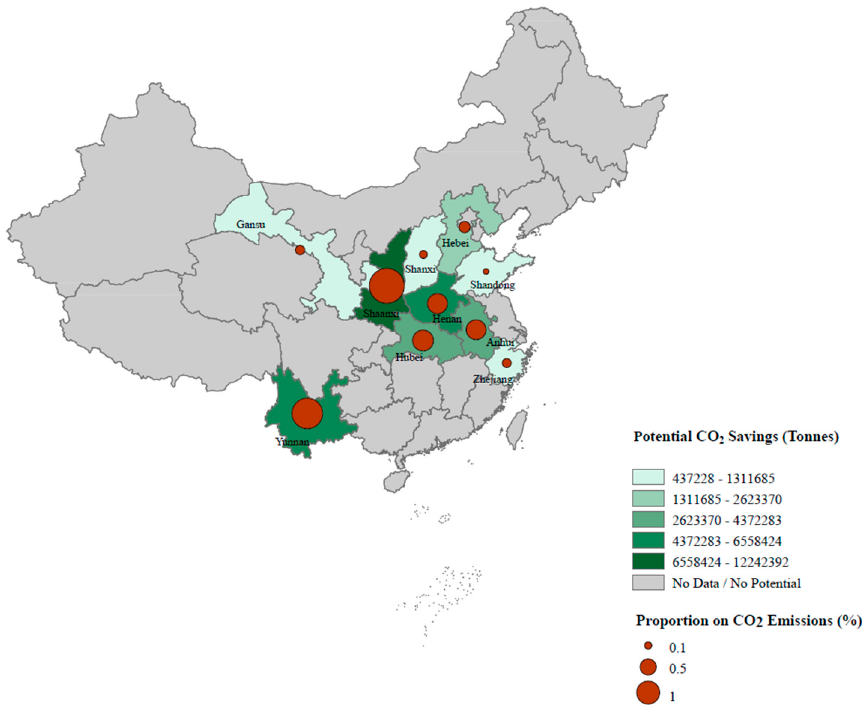
Figure 6. Chinese provinces planting Pistacia chinensis and the potential for annual carbon savings on total control CO 2 emissions.